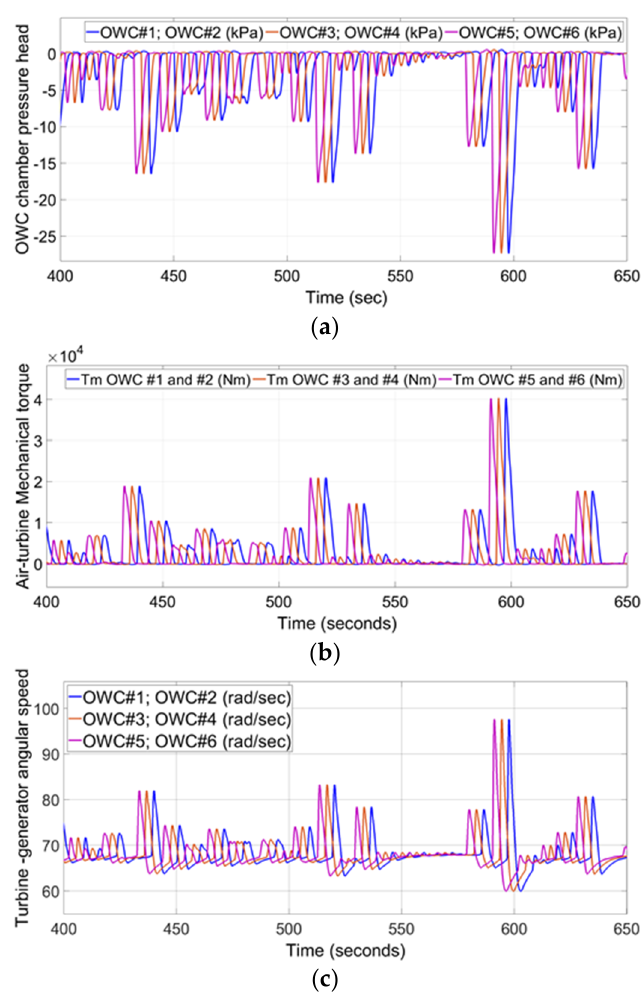
Figure 5. Third case study. ( a ) VOWC chamber pressure head for #1, #3, and #5, ( b ) air turbine #1, #3, and #5 mechanical torque, ( c ) turbine-generator #1, #3, and #5 rotor angular speed (ω m ).